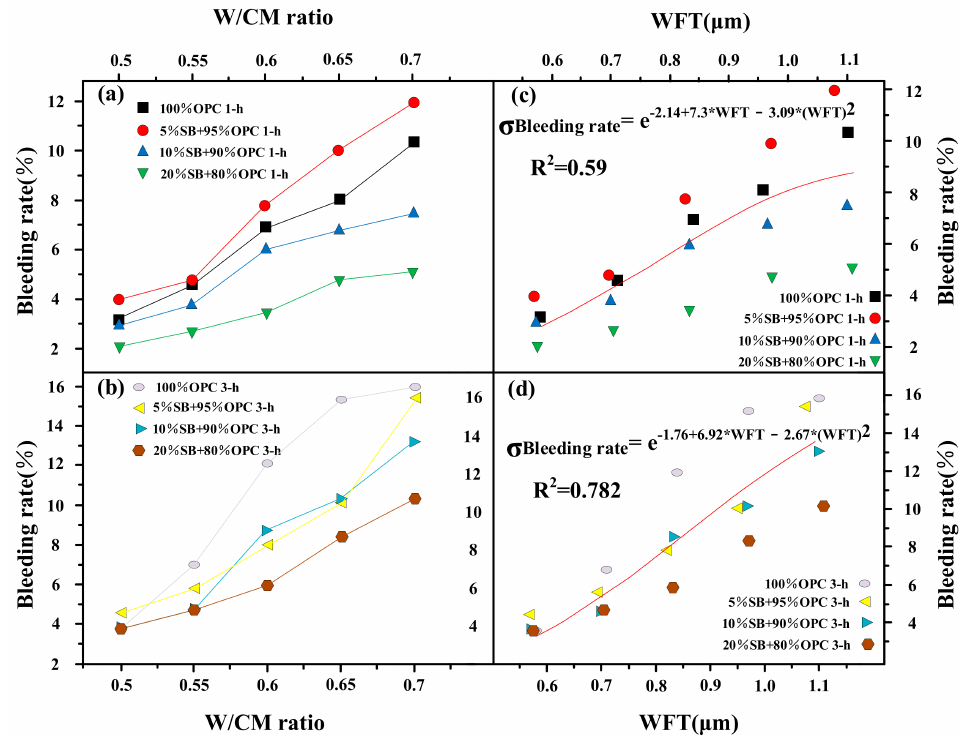
Figure 8. Bleeding rate versus W/CM ratio ( a , b ) and WFT ( c , d